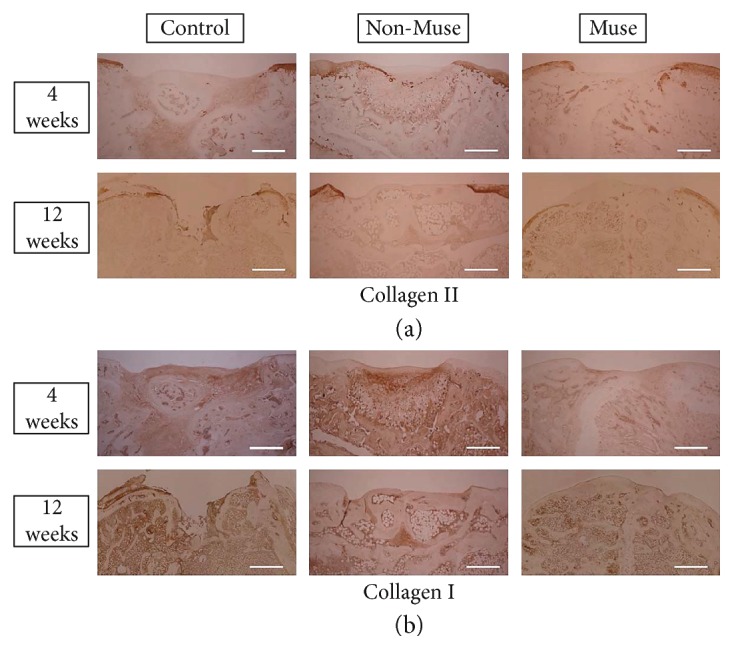
Immunohistochemical staining of collagen type I and II. There was no detection of collagen type I and II in the repaired tissue of the Muse group. Scale bars 500 μm.